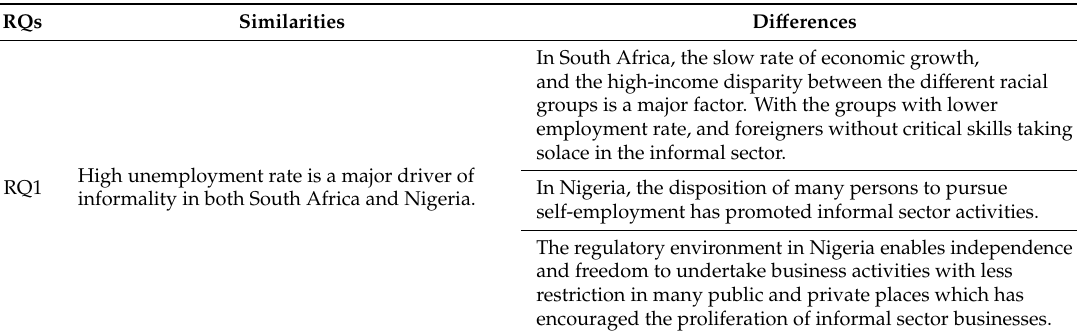
Table 15. Summary of findings of the comparison of SA and Nigeria